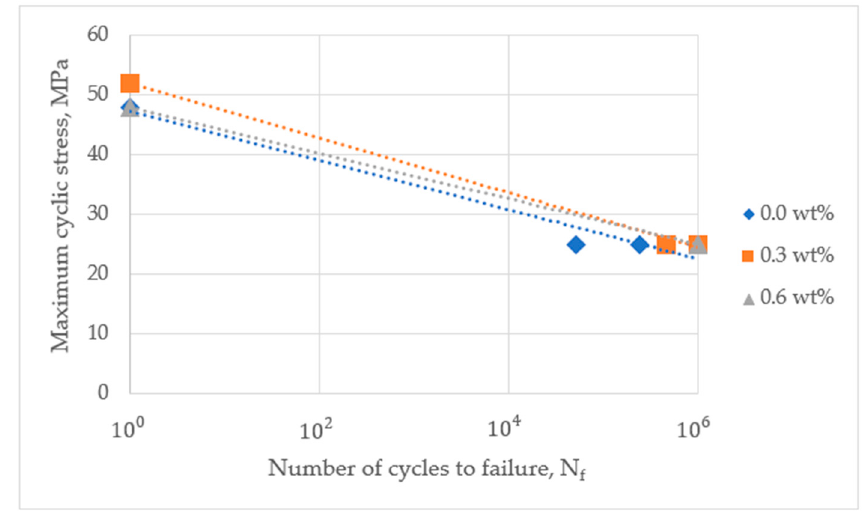
Figure 17. The number of cycles to failure of composite reinforced by 1 mm carbon fiber length under cyclic loading.